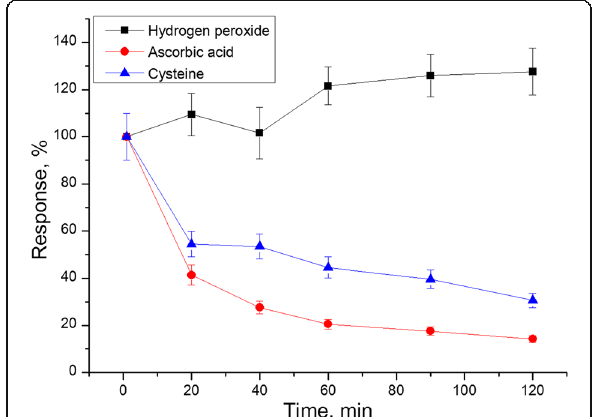
Fig. 5 Stability of the PPD membrane during 2 hours. The responses to three substances were normalized to the initial response to the corresponding substance after PPD deposition